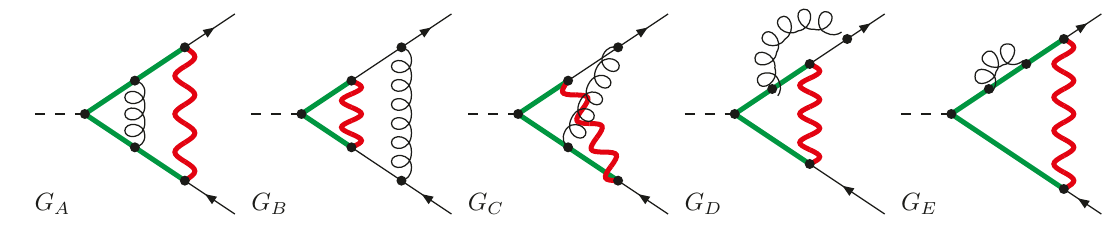
Figure 1 . Examples of Feynman diagrams contributing to the mixed decay H b (cid:22) b through a Ht (cid:22) t -coupling. The Higgs boson is denoted by a dashed line, a top quark ! by a green line, a bottom quark with a black line and a gluon by a curly line. Particles with mass m W are drawn with a wavy